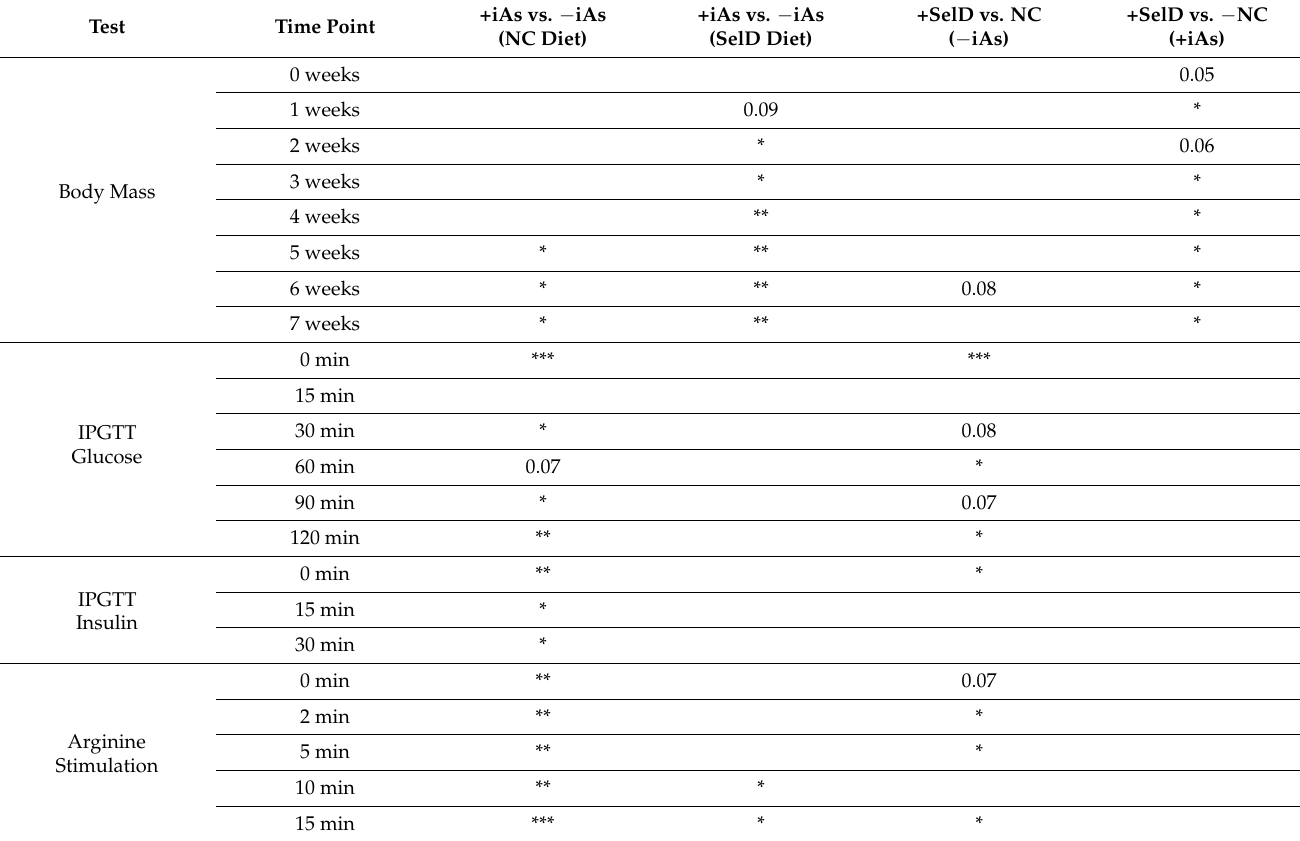
Table 1. Summary of metabolic effects of arsenic exposure and/or selenium status (* p < 0.05, ** p < 0.01, *** p < 0.001).